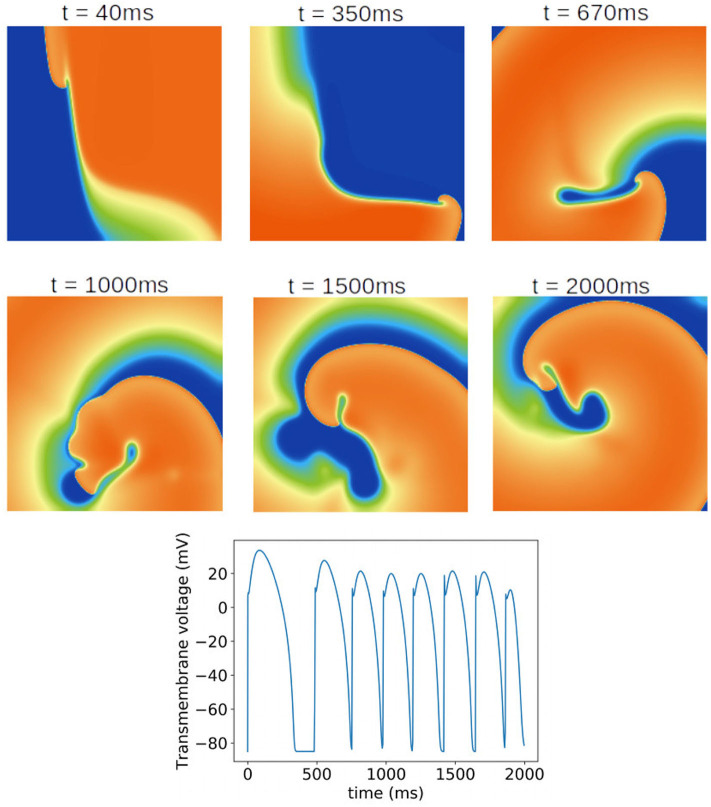
Baseline spiral wave simulation using mean values of all parameters. A rotating spiral wave was induced on a square two-dimensional sheet by setting gradients in voltage and h at t = 0. (Top) Progression of the spiral wave at selected times (color represents transmembrane voltage). Number of phase singularities in snapshots: 40 ms: one; 350 ms: one; 670 ms: one; 1,000 ms: three; 1,500 ms: one; 2,000 ms: three. (Bottom) Transmembrane voltage as a function of time for the node at the center of the tissue.